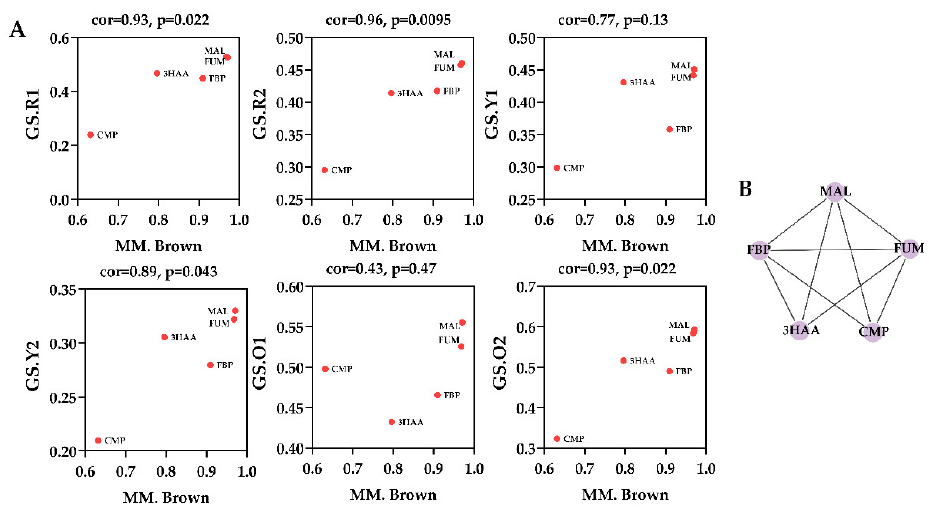
Figure 4. Identification of hub metabolites. ( A ) Scatterplot of MS vs. MM in the brown module. ( B ) Intramodular connections within the brown module. FUM, fumarate; MAL, malate; CMP, cytidine monophosphate; FBP, fructose 1,6-bisphosphate; 3HAA, 3-hydroxyanthranilic acid.